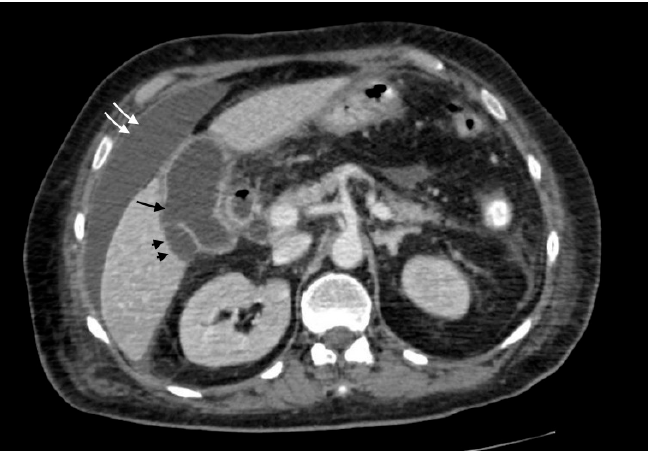
Figure 4. Gallbladder perforation: transmural defect of the gallbladder wall (black arrow) with pericholecystic effusion (head arrows) and perihepatic peritoneal collection, suggestive of biliary peritonitis (white arrows).